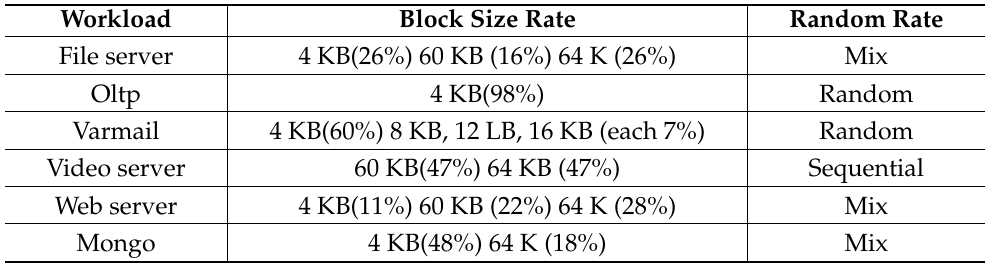
Table 2. Characteristics of Filebench